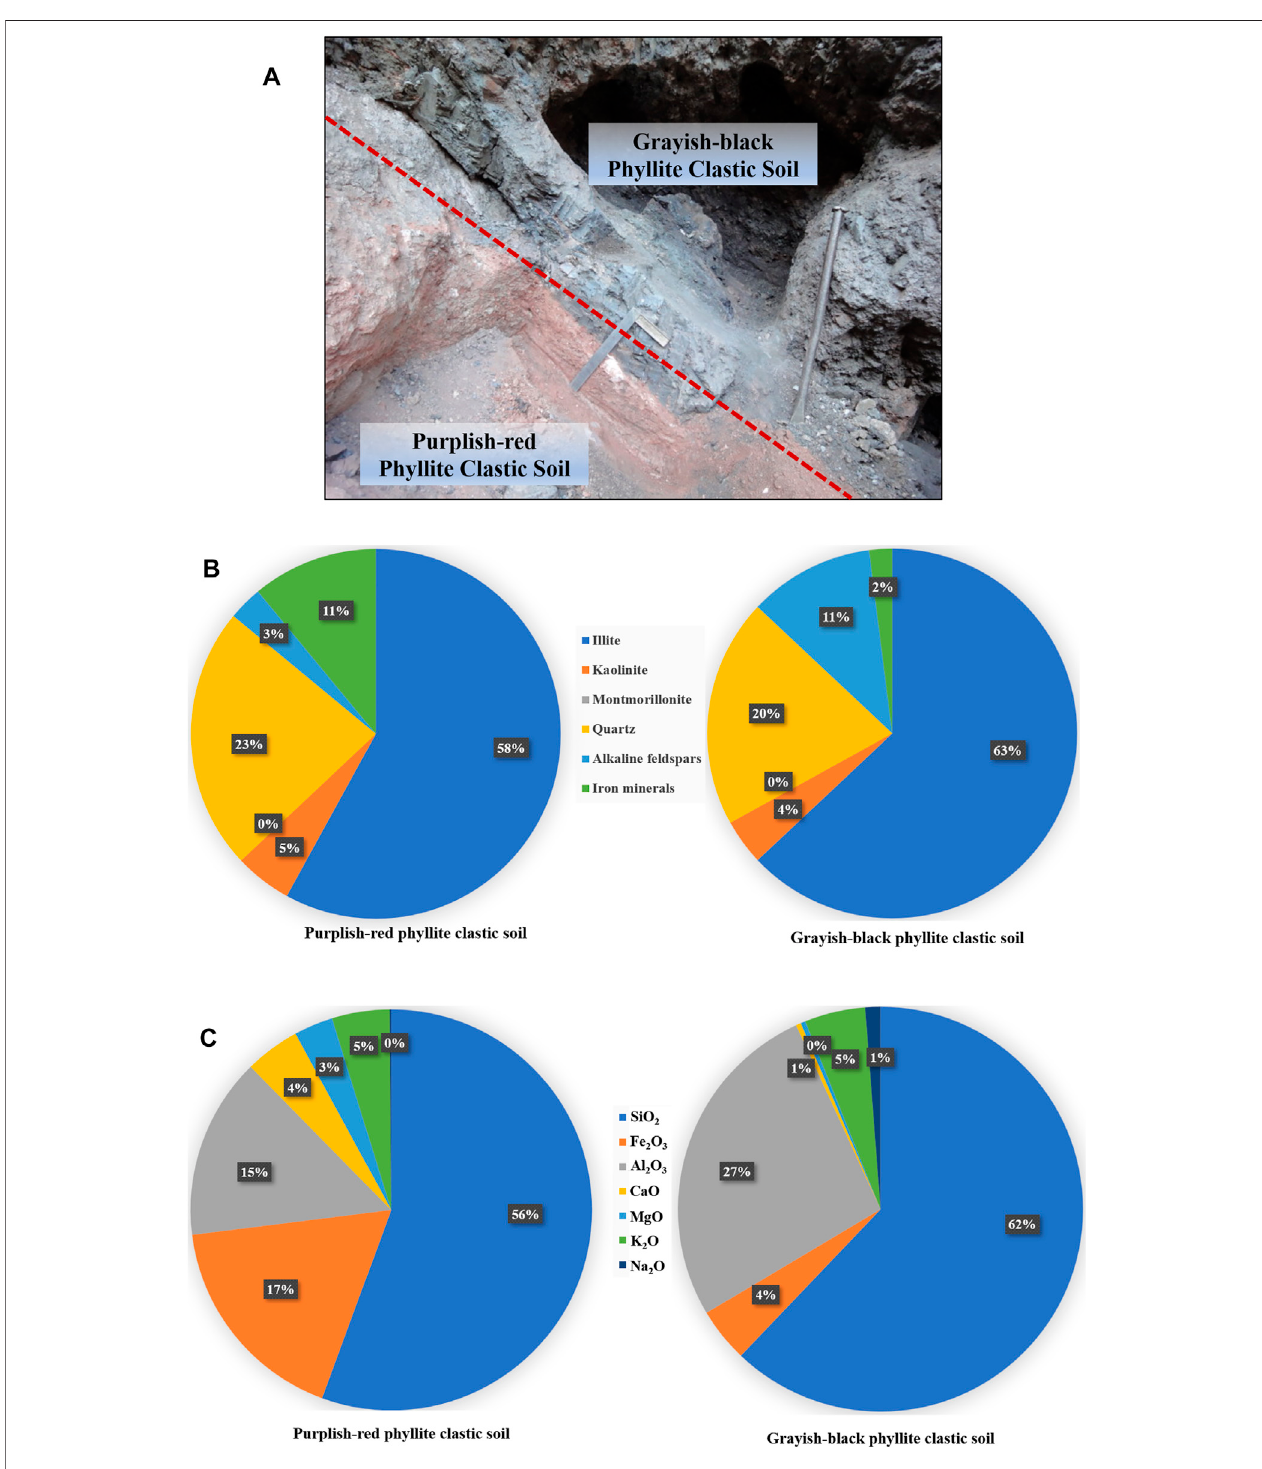
FIGURE 1 | Phyllite clastic shear band: (A) photograph; (B) mineral composition; (C) chemical composition.